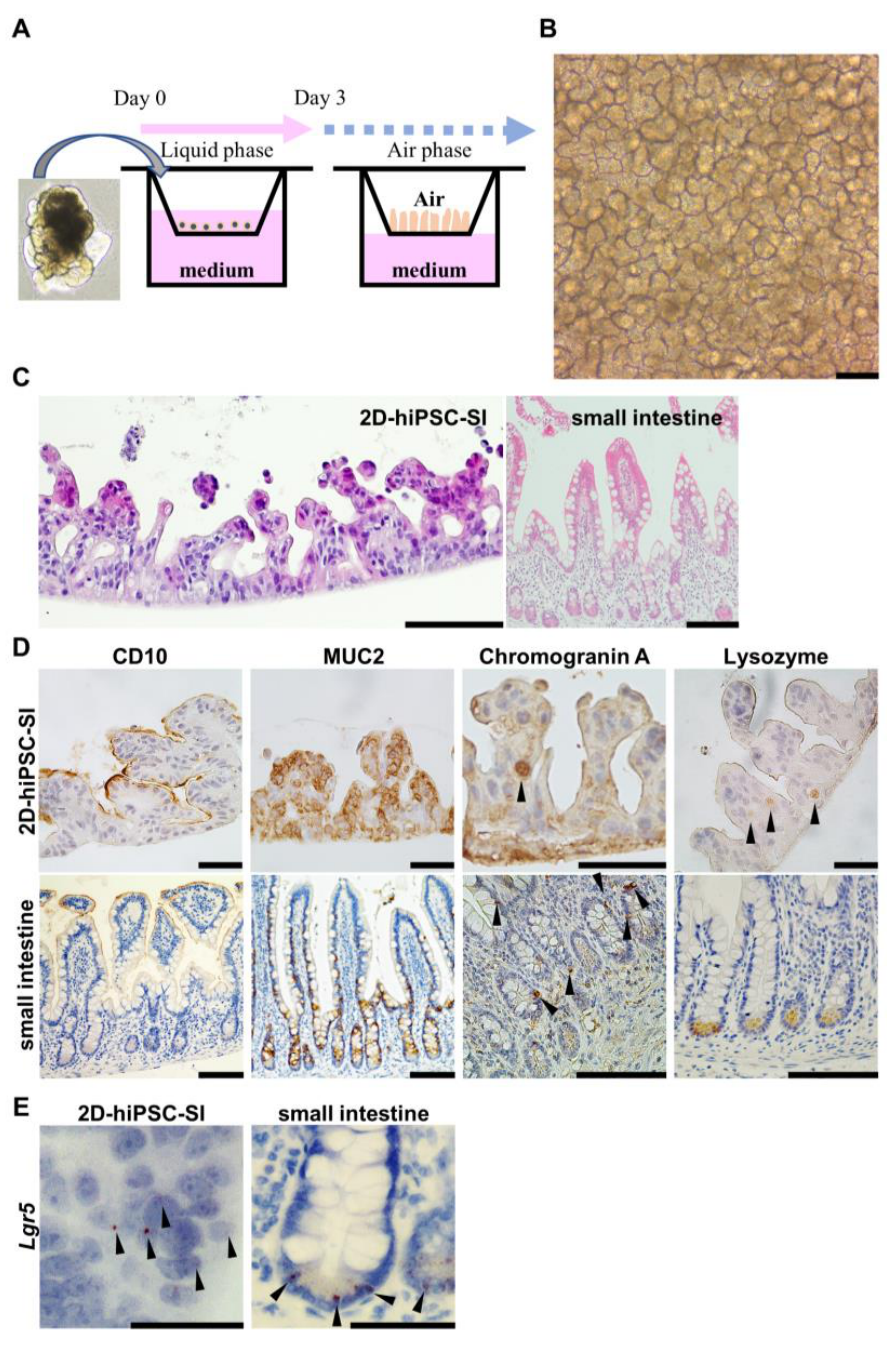
Figure 1. Multi-lineage differentiation of human iPSC-derived 2D monolayer small intestine. ( A ) Schematic diagrams of human iPSC-derived 2D monolayer crypt-villus structural small intestine (2D-hiPSC-SI). Cells were seeded from human iPSC-derived small intestinal budding organoids and cultured at the ALI. ( B ) Phase-contrast microscopy on culture day 8. ( C ) Hematoxylin-eosin staining showed a crypt-villus structure in cultured 2D-hiPSC-SI at day 8, similar to the small intestinal epithelium in vivo. ( D ) Immunohistochemistry staining for intestinal epithelial cell markers. CD10, absorptive cell marker; MUC2, goblet cell marker; chromogranin A, enteroendocrine cell marker; lysozyme, Paneth cell marker. Left, 2D-hiPSC; right, human small intestine in vivo. ( E ) RNA in situ hybridization of Lgr5 of our model and human small intestine. Black arrowheads show positive staining for the respective markers. Scale bars: 100 µm ( B – D ); 50 µm ( E ). 3.2. ASA-Induced Small Intestinal Injury in 2D-hiPSC-SI To investigate of the effects of ASA on the small intestinal mucosa, ASA was added to the basal side (well-plate side) of the 2D-iPSC-SI on culture day 8, when morphological examination of the 2D-iPSC-SI revealed a mature villus structure under ALI culture con- ditions (Figure 2A). Time-course analysis showed that the macroscopic appearance was